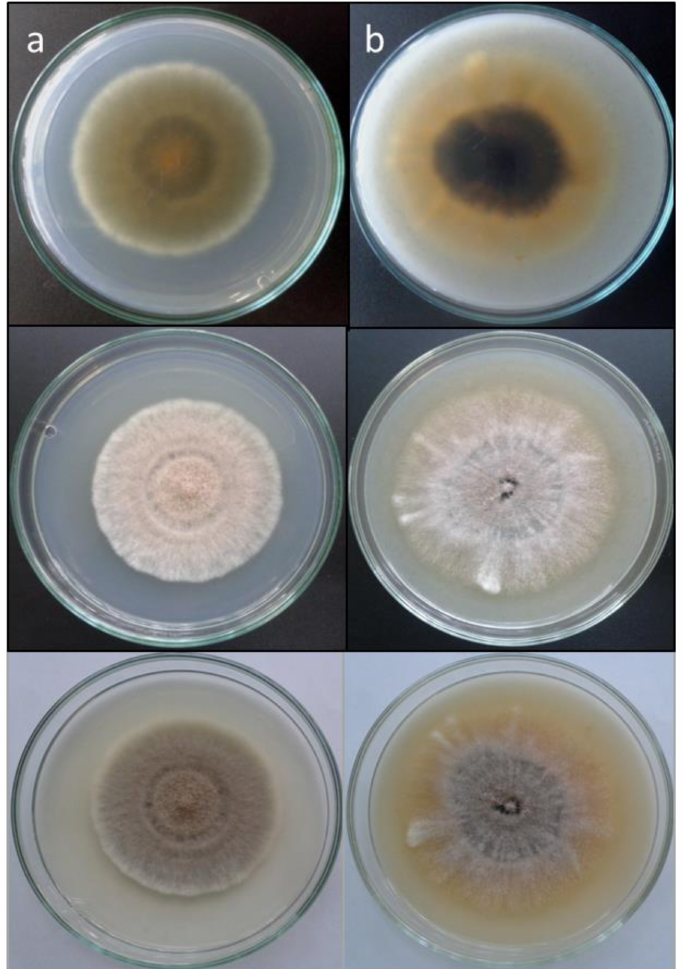
Figure 2. Scedosporium aurantiacum DMic 175378. ( a ) Colony on PDA (column, from top to down: reverse and surface on a black background, and surface on a white background) after 14 days at 25 ◦ C. ( b ) Colony on OA (same explanation than previously) after 14 days at 25 ◦